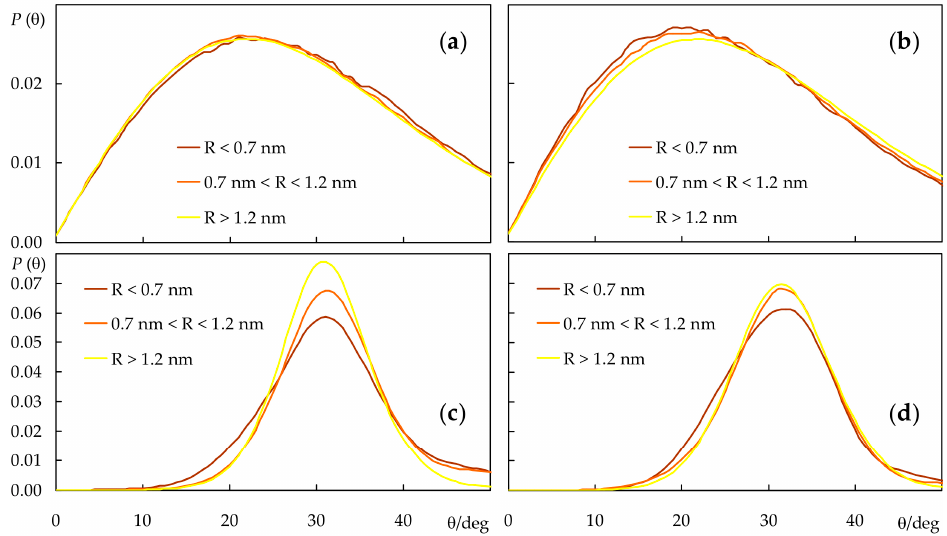
Figure 7. sn -1 acyl chain long axis (defined as the vector from the terminal to the first C atom) distributions of POPC ( a , b ) and DPPC ( c , d ), in the presence of c -PnA ( a , c ) or t -PnA ( b , d ). Each curve concerns a different range of distances R between the centers of mass of the lipid and the nearest probe.